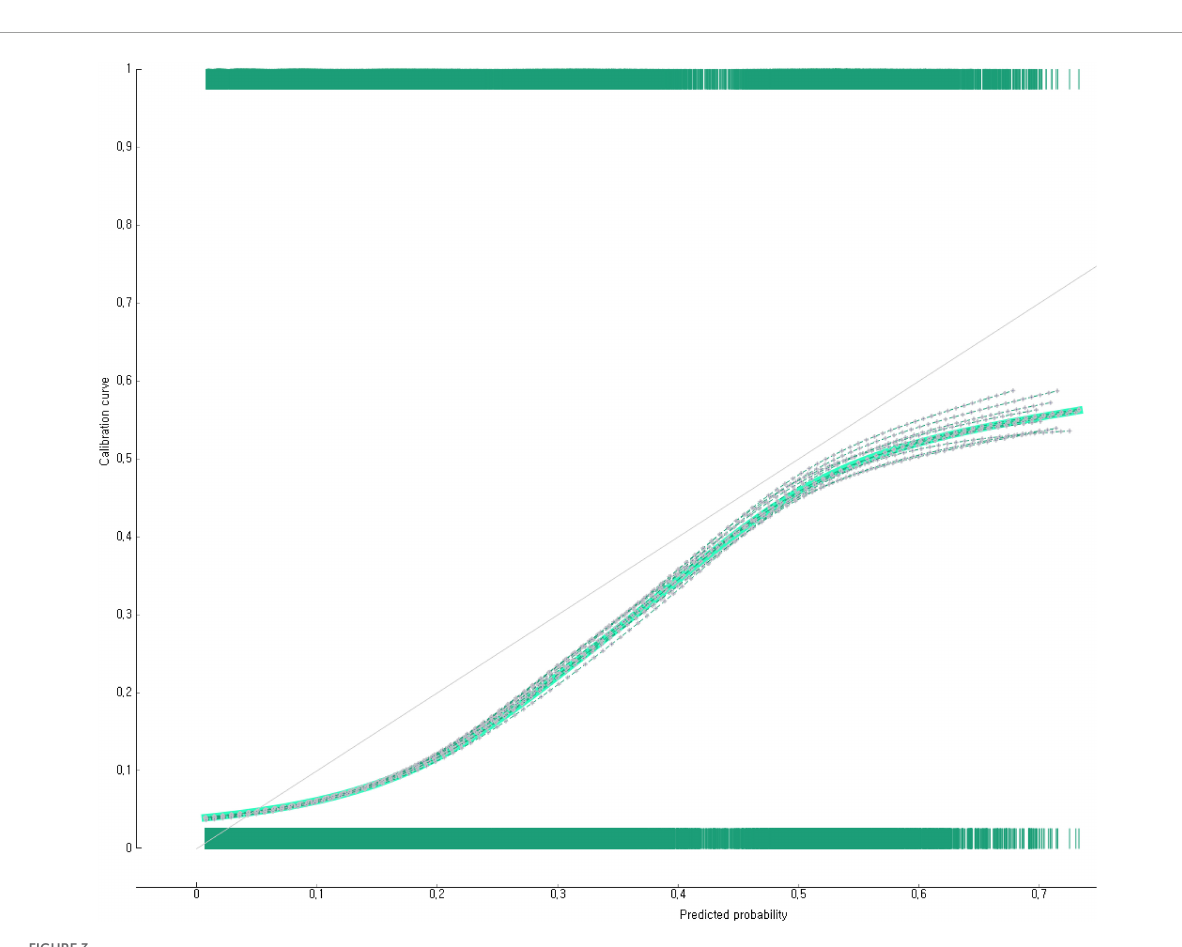
FIGURE3 A calibration plot to identify the performance of the nomogram to predict the South Korean adolescent group vulnerable to suicidal